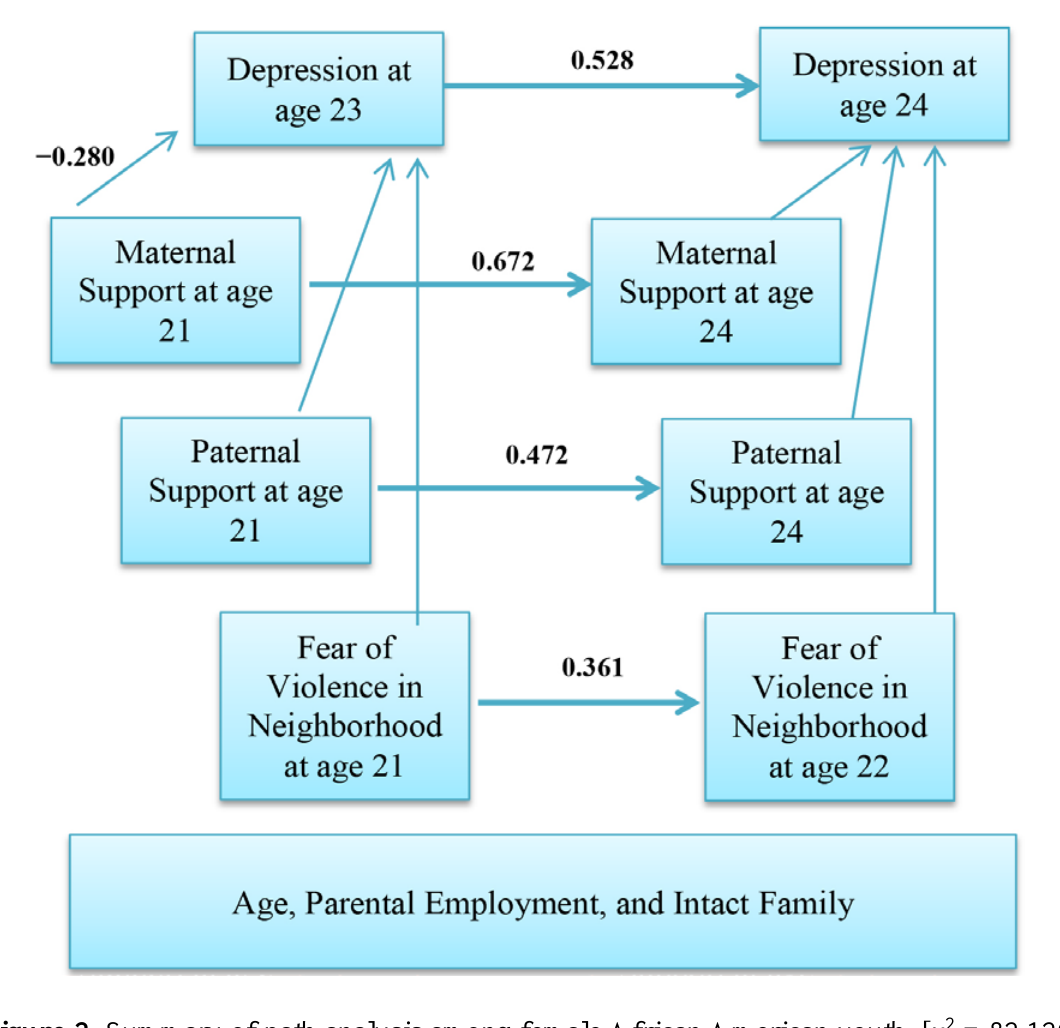
Figure 2. Summary of path analysis among female African American youth. [χ 2 = 82.126, df = 52, p = 0.005, χ 2 / df = 1.579, RMSEA = 0.029, (90% CI = 0.016, 0.041)]. Paths from covariates and also covariance between exogenous variables are not shown in this model. Numbers are standardized regression coefficients. Significant regression coefficients have been shown in